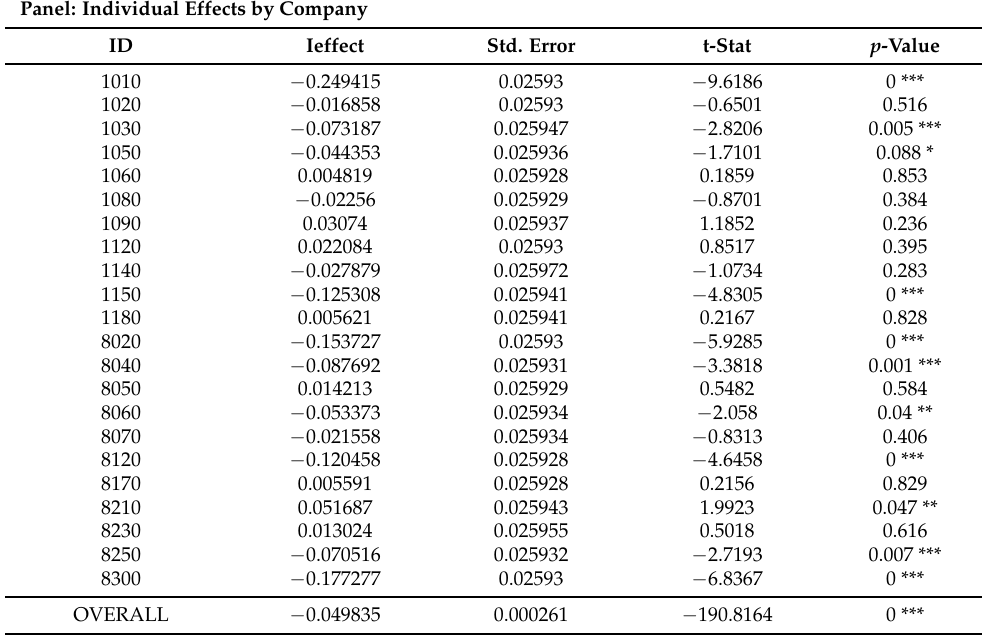
Table A1. Relationship between extra return, oil and trading volumes before the COVID-19 pandemic. Panel: Individual Effects by Company